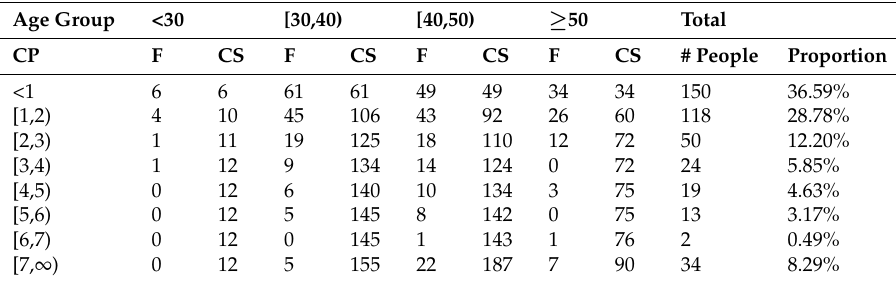
Table 3. Distribution of authors by age group and relative productivity.